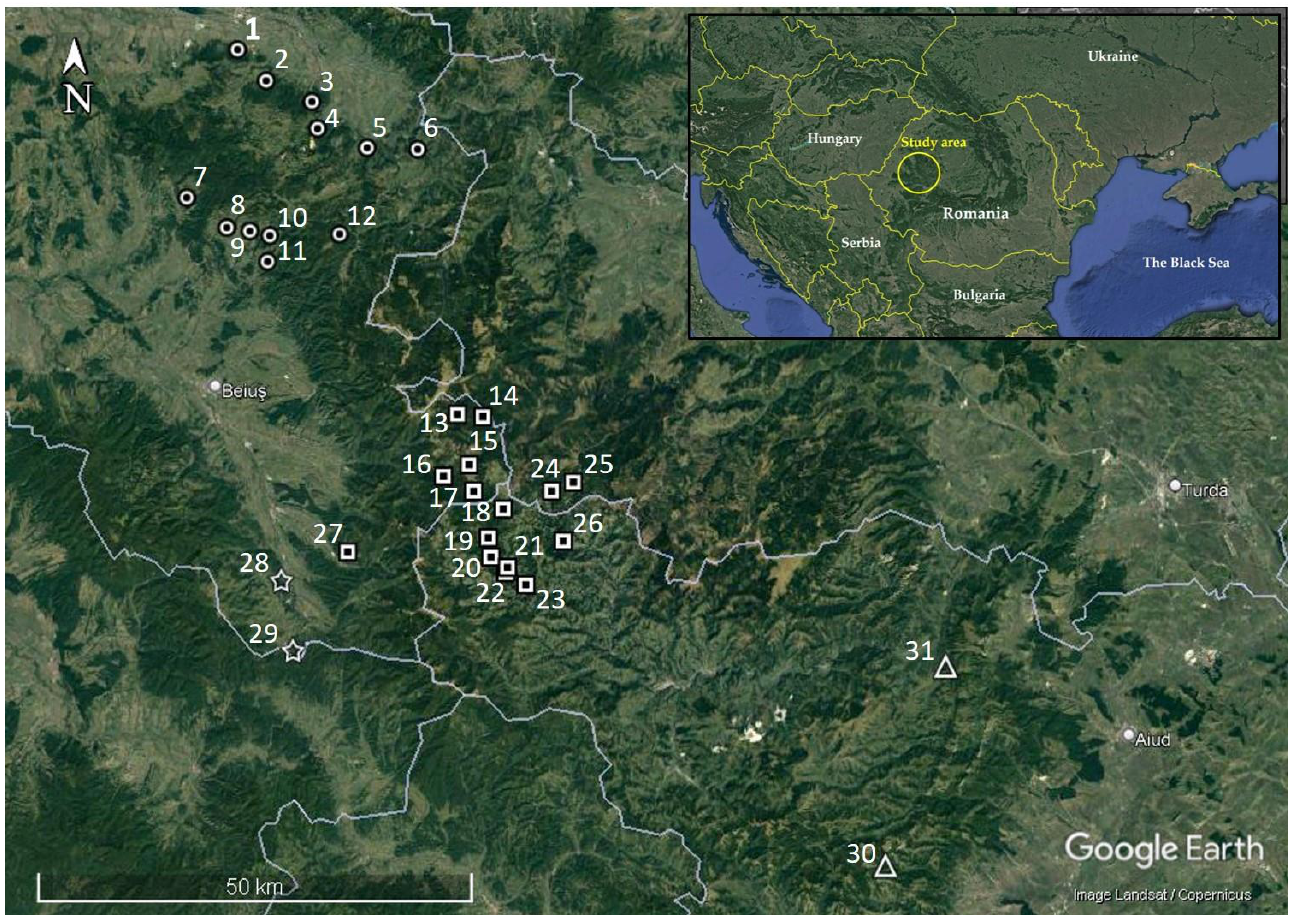
Figure 1. Locations of the 31 sampling springs in the Apuseni Mountains, Transylvania, Romania: the Pădurea Craiului Mountains (circles); the Bihor–Vlădeasa Mountains (squares); Platoul Vașcău (stars); the Trascău Mountains (triangles) . The sampling codes are the same as those in Table 1 (image source: Google Earth Pro 7.3.4.8248).